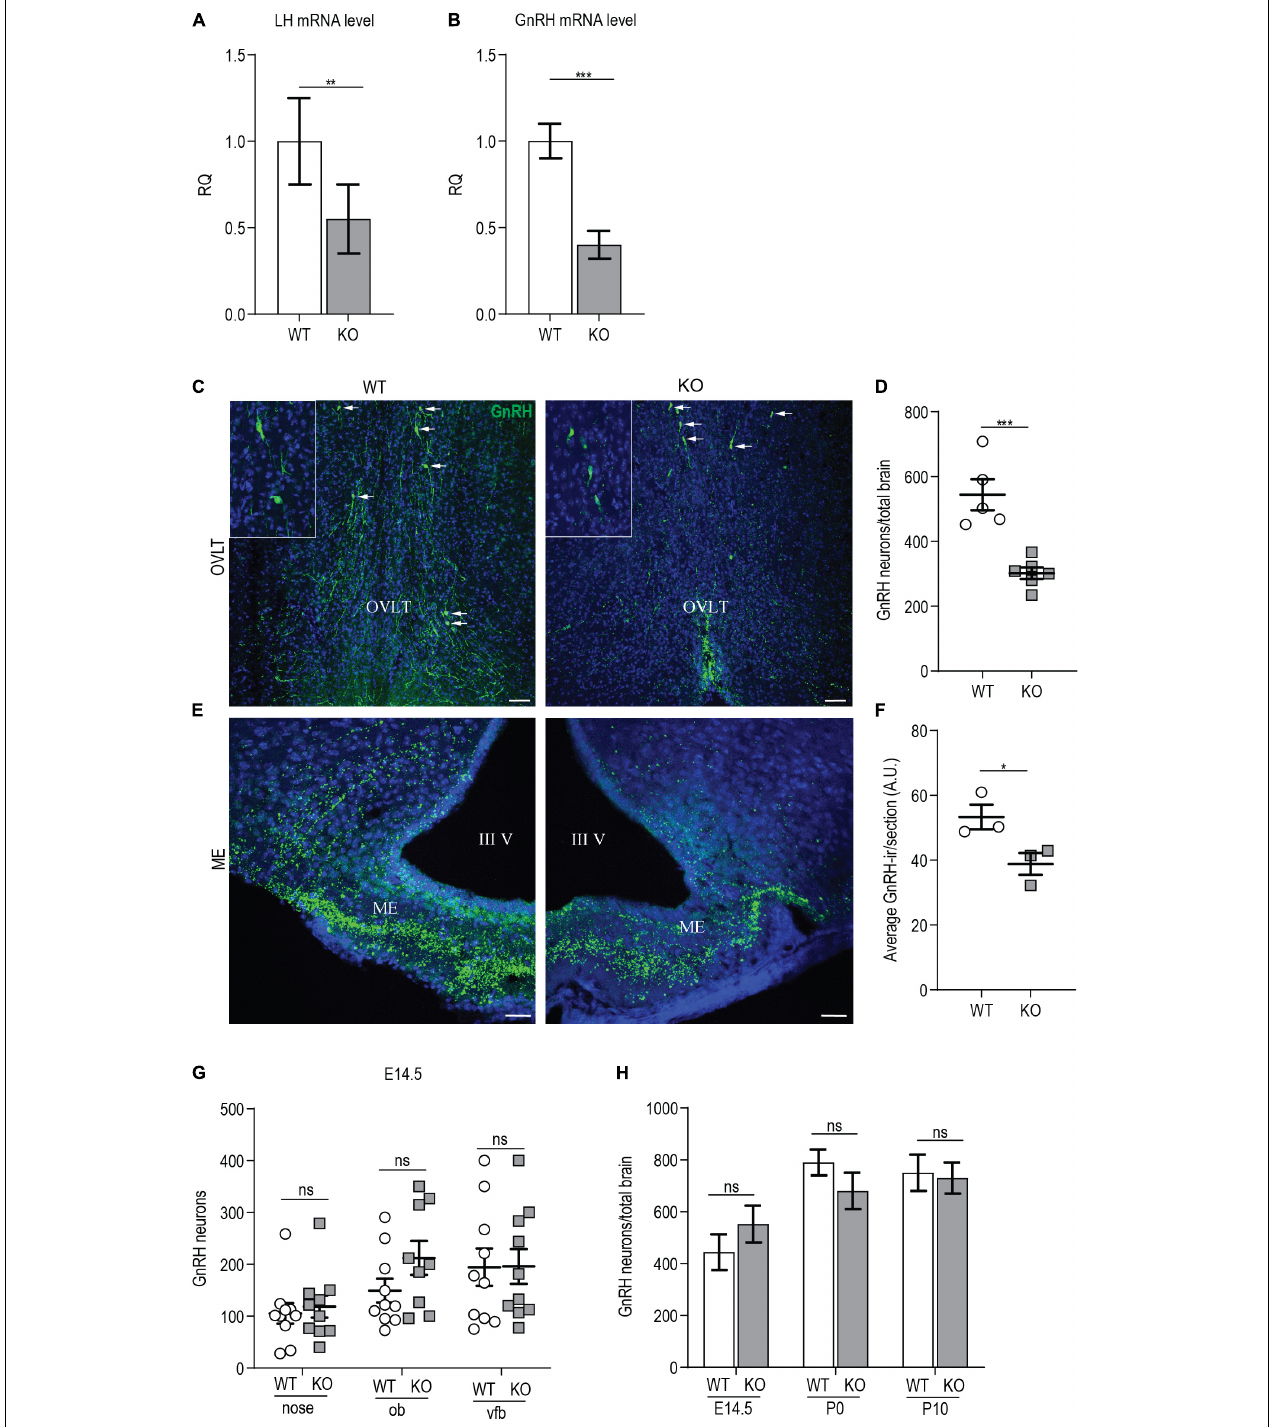
FIGURE 5 | p140Cap KO females show reduced number of GnRH neurons. (A) LH mRNA expression in the hypophysis of p140Cap KO and WT adult females, evaluated by real-time quantitative PCR. n = 12 WT mice; 15 KO mice. Unpaired, two-tailed t -test, P = 0.006. (B) GnRH mRNA expression in the hypothalamus of p140Cap KO and WT adult females, evaluated by real-time quantitative PCR. n = 4 WT mice; 6 KO mice. Unpaired, two-tailed t -test, P < 0.001. (C) Maximum intensity projections of z-stack images (10 serial image planes; z step size = 1 µ m) of the expression of GnRH (green) in the OVLT and ME of adult p140Cap KO and WT adult female brains. Sections were counterstained with DAPI (blue). Scale bar: 75 µ m. (D) Number of GnRH neurons in the hypothalamus of adult p140Cap KO and WT females. n = 5 WT mice; 6 p140Cap KO mice. Unpaired, two-tailed t -test, P < 0.001. (E) Maximum intensity projections of z-stack images (10 serial